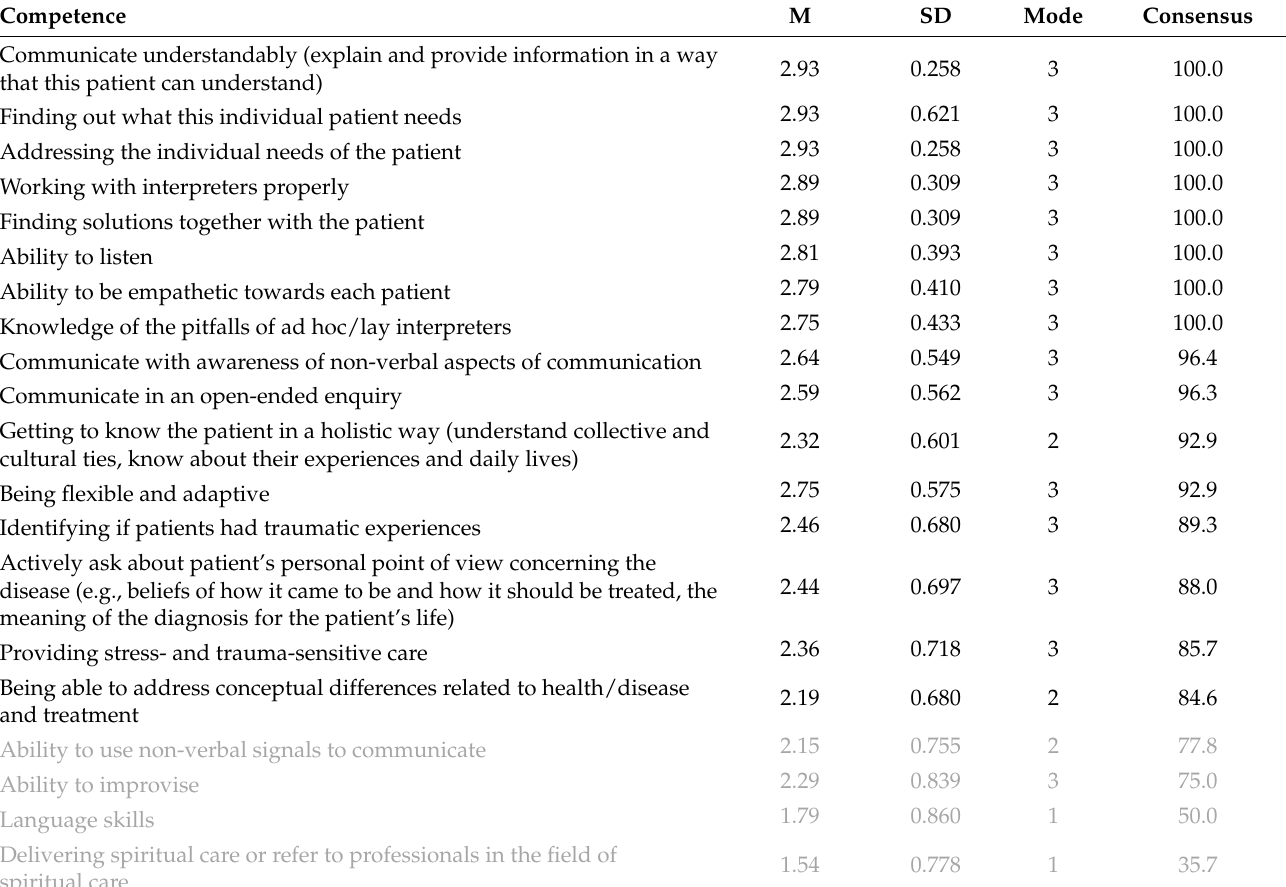
Table 6. Ranking according to consensus in the pragmatic